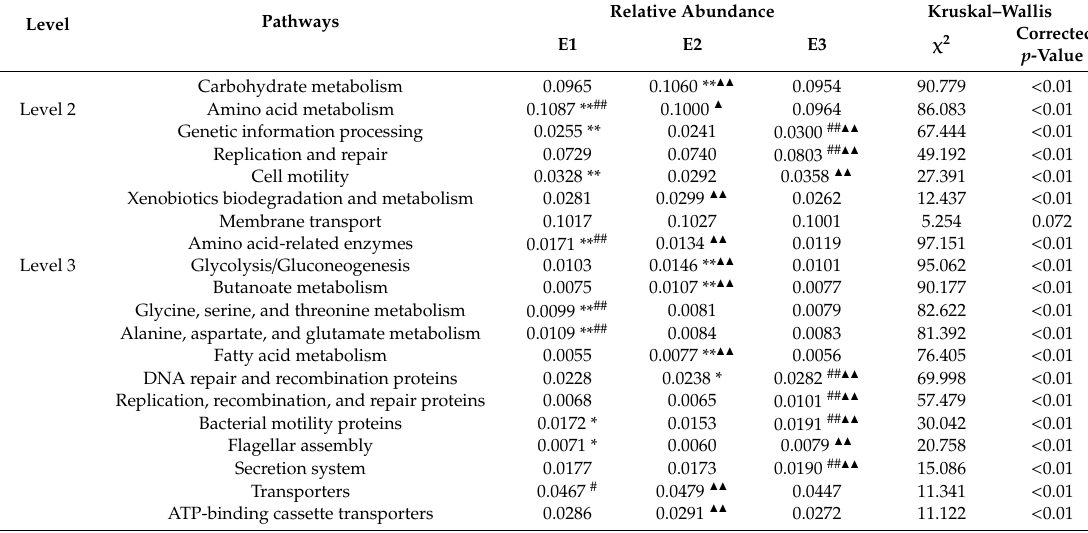
Table 2. Average relative abundances of hierarchical functional categories (Kyoto Encyclopedia of Genes and Genomes (KEGG) pathway levels 2 and 3) among the three enterotypes. p -values had been corrected using the false discovery rate control. All pairwise analysis of the Kruskal–Wallis test was used for post hoc multiple comparisons and significant di ff erences were denoted as: E1 vs.